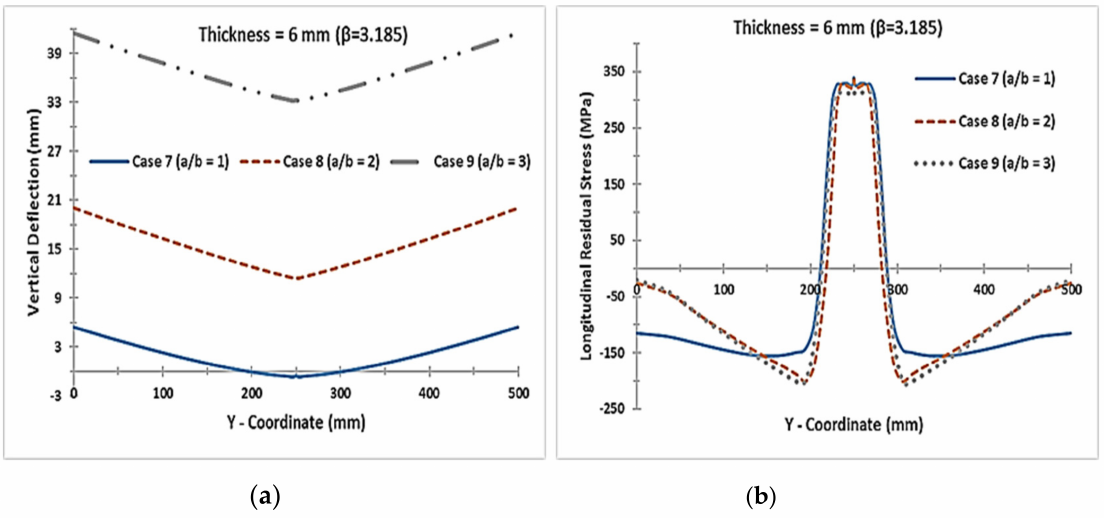
Figure 11. ( a ) Vertical deflection along line C-D and ( b ) longitudinal residual stress along line C-D. Figure 12 shows the simulation results obtained in 6 mm thickness plates (Cases 7 to 9). Figure 12a shows the vertical deflection distribution at the mid-span along line C-D on the bottom surface of 8 mm plate thickness ( t ) with a 2.389 plate slenderness ratio ( β ) for three different plate aspect ratios ( a / b ) 1, 2 and 3. It is shown that the effect of plate aspect ratio ( a / b ) on the plate vertical deflection highly increases as the plate slenderness ratio increases (thin thicknesses). The vertical deflection at the mid-span of the plate’s longitudinal edge for the three different plate aspect ratios a / b = 1, 2 and 3 are 5.4, 18.6 and 41.5 mm, respectively.